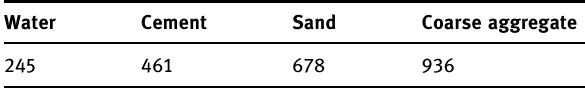
Table 9: Mix proportion of recycled concrete ( unit: kg · m − 3